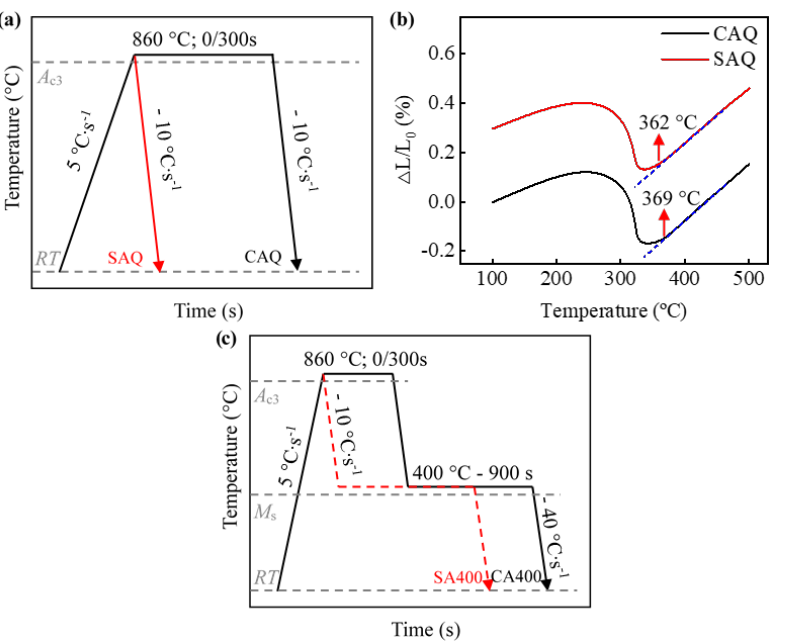
Figure 1. ( a ) Quenching processes; ( b ) dilatation curves of direct quenched samples; ( c ) schematic illustration of heat-treatment processes . Δ L : the length change; L 0 : the initial length. Samples with dimensions of 1.5 × 60 × 150 mm 3 were cut from the cold-rolled sheets.